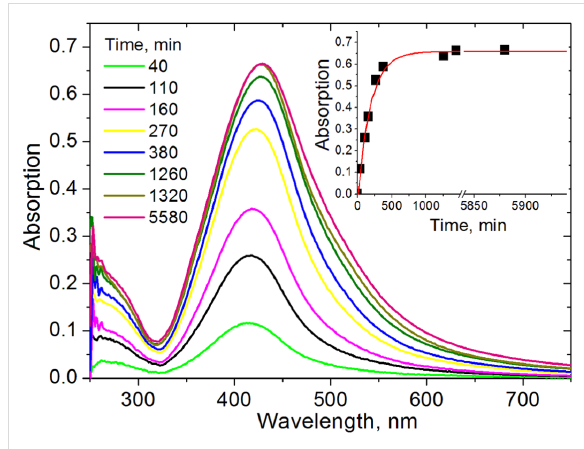
Figure 2: Immobilization kinetics of Ag NPs on a glass substrate. Since the glass slides were modified on both sides, the spectra corre- spond to the absorption of two NPs layers.